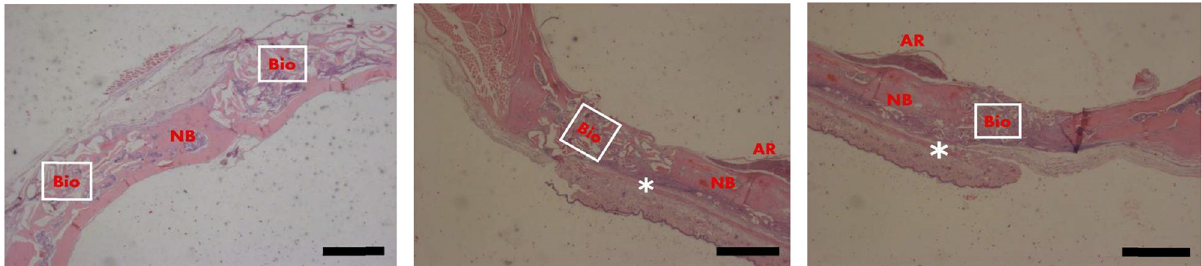
Figure 5: Photomicrographs of slides stained with hematoxylin and eosin ( HE ) . ( left side picture ) Sample cut from the region above the defect without membrane. ( middle picture ) Samples cut from the defect fi lled with Bio Oss ® biomaterial and covered with an experimental membrane. Sixty days after the surgery. ( * ) membrane. ( right side picture ) Samples cut from the defect fi lled with Blue Bone ® biomaterial and covered with an experimental membrane. Sixty days after the surgery. ( * ) membrane. NB = native bone; Bio = biomaterial; AR = artery. Scale bar = 100 µm, 25 × magni fi cation.